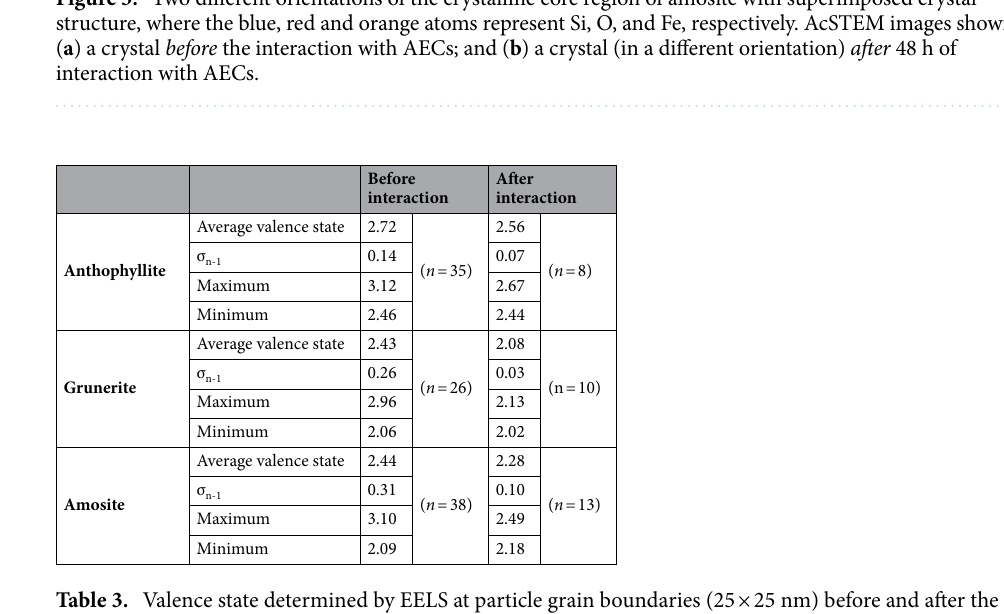
Table 3. Valence state determined by EELS at particle grain boundaries (25 × 25 nm) before and after the interaction with AECs.